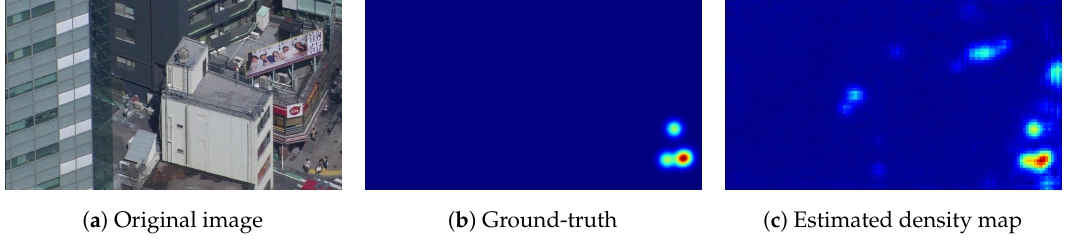
Figure 1. Sample image exhibiting the problem of “fake human” detection. It is clear that the billboard with humans on top of the building produces false positive